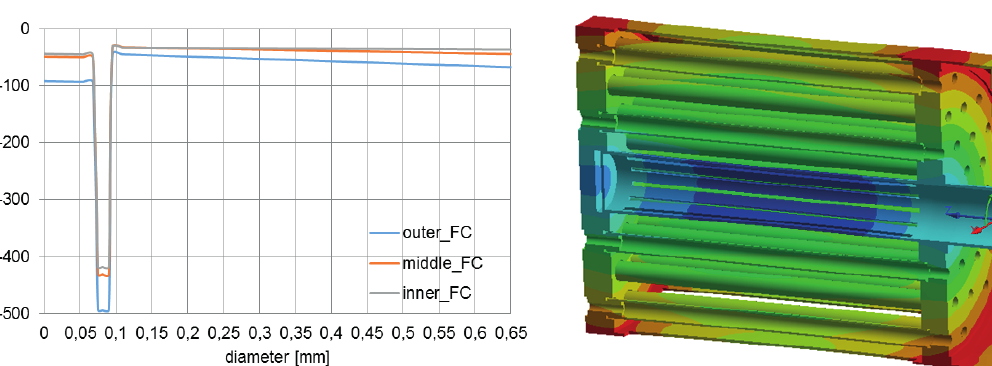
Figure 24: Axial displacement of the assembly with supporting structure under thermal stresses.